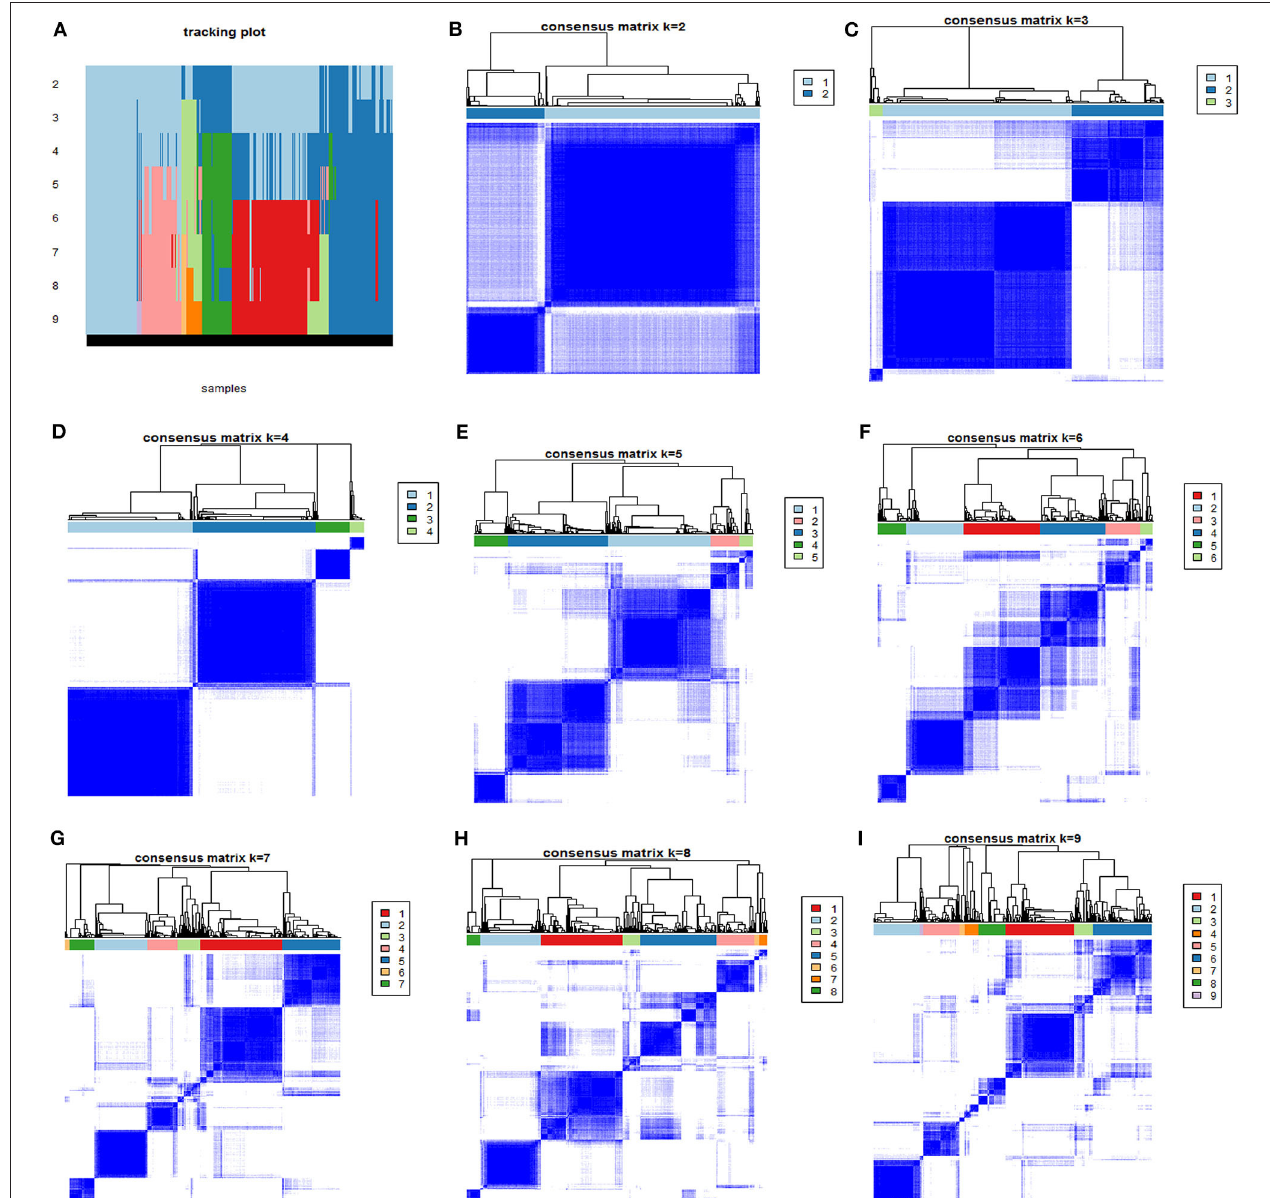
FIGURE 1 | The consensus matrix heatmaps of consensus k-means clustering. (A) Shows the sample distribution of 4 phenotypes after consensus k-means clustering. (B–I) Shows consensus matrix heatmaps of different subgroup numbers ( k = 2, 3, 4, 5, 6, 7, 8, and 9). When k = 4, the model exhibited the clearest separation of the consensus matrix